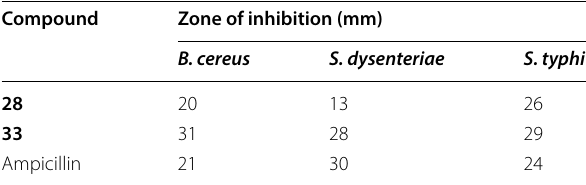
position. The results of synthesized compounds pre- sented in Table 3.